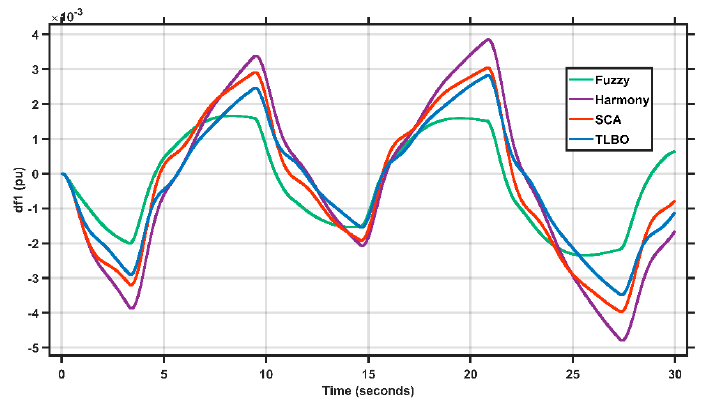
Figure 21. Change in area 1 frequency under wave disturbance.